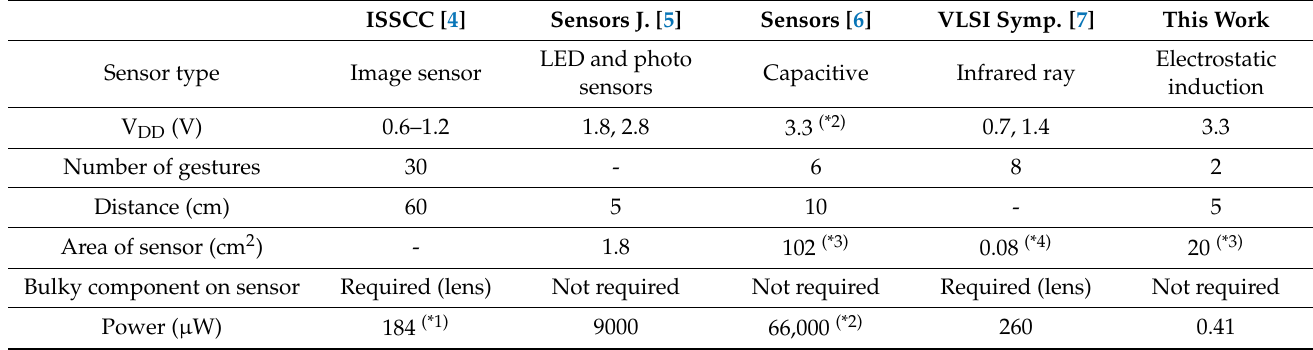
Table 1. Comparison of the proposed hand gesture sensor with conventional